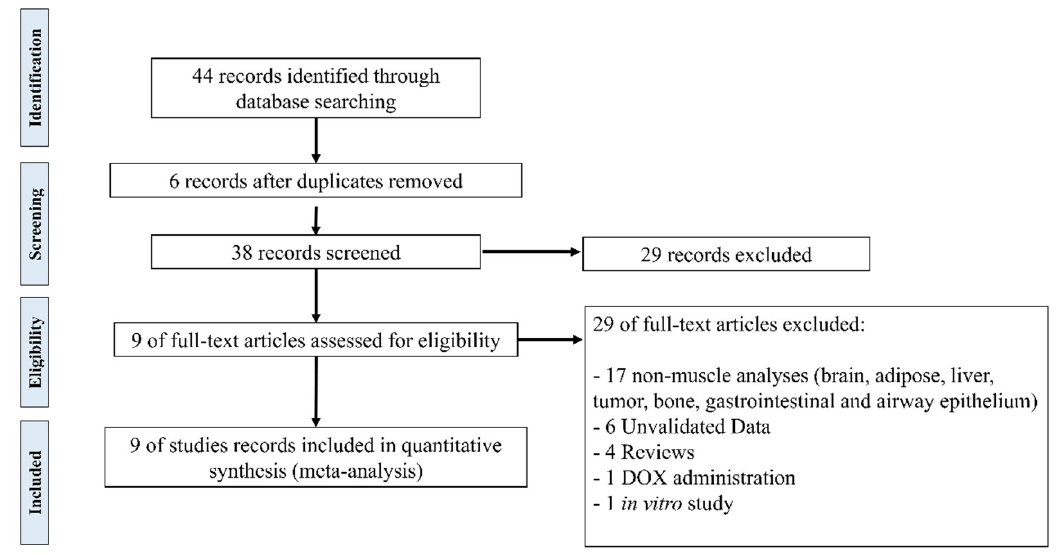
Figure 1. Flow chart of literature search in the meta-analysis.